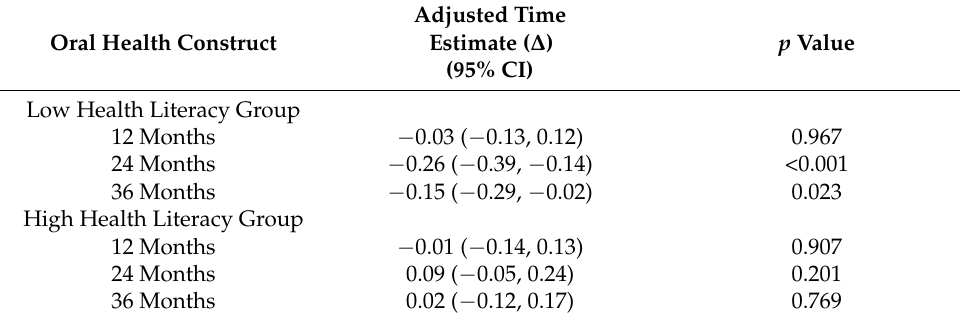
Table 3. Change over Time in External LOC—Chance by Health Literacy Category 1